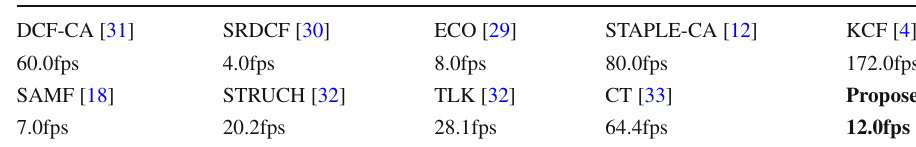
Table 1 The comparison of calculated time among competitors and proposed